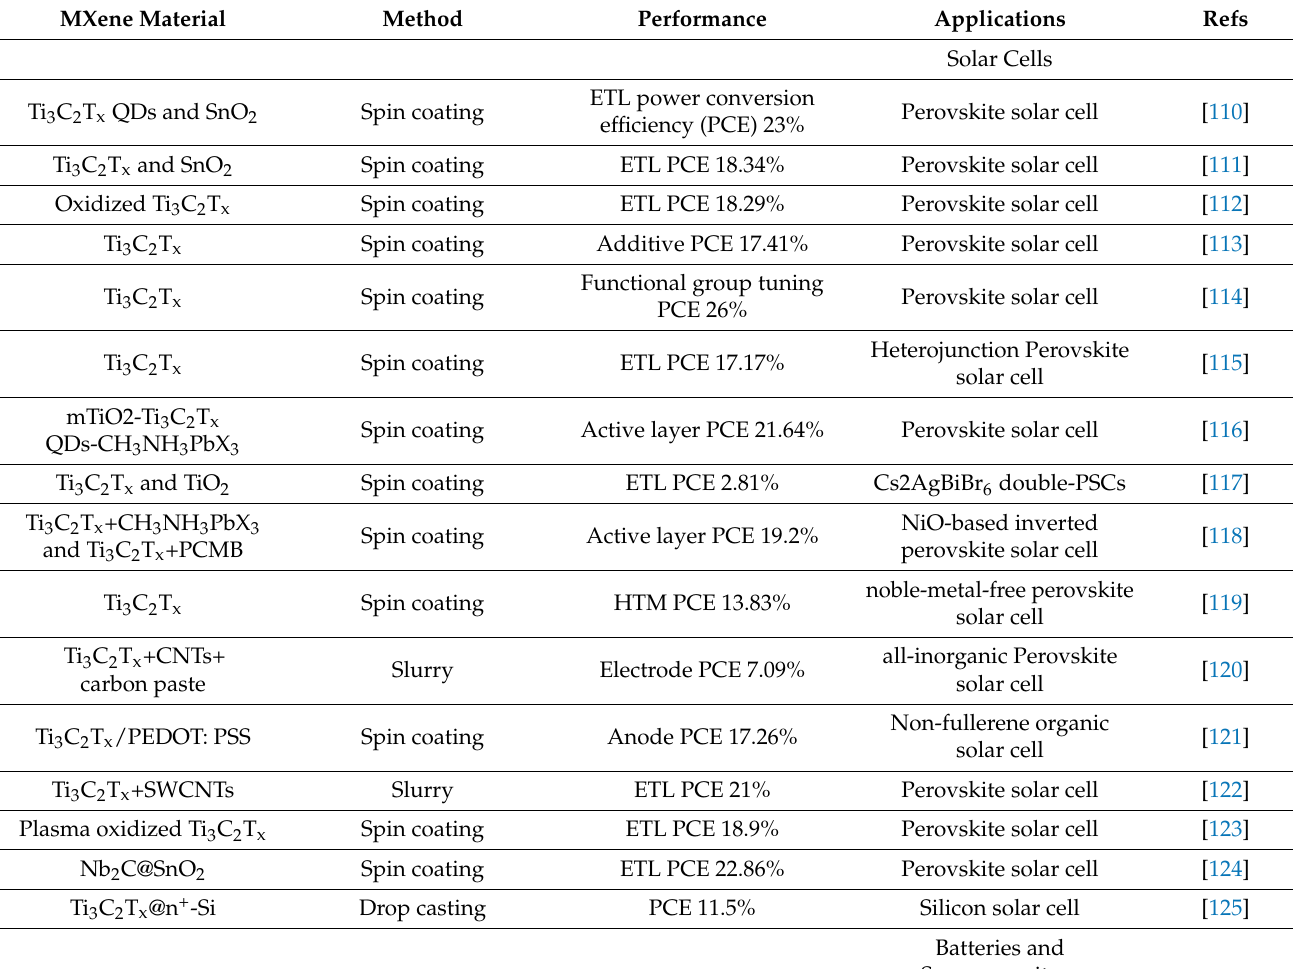
Table 1. Summary of MXene materials films synthesized using different methods and their applica- tions in energy